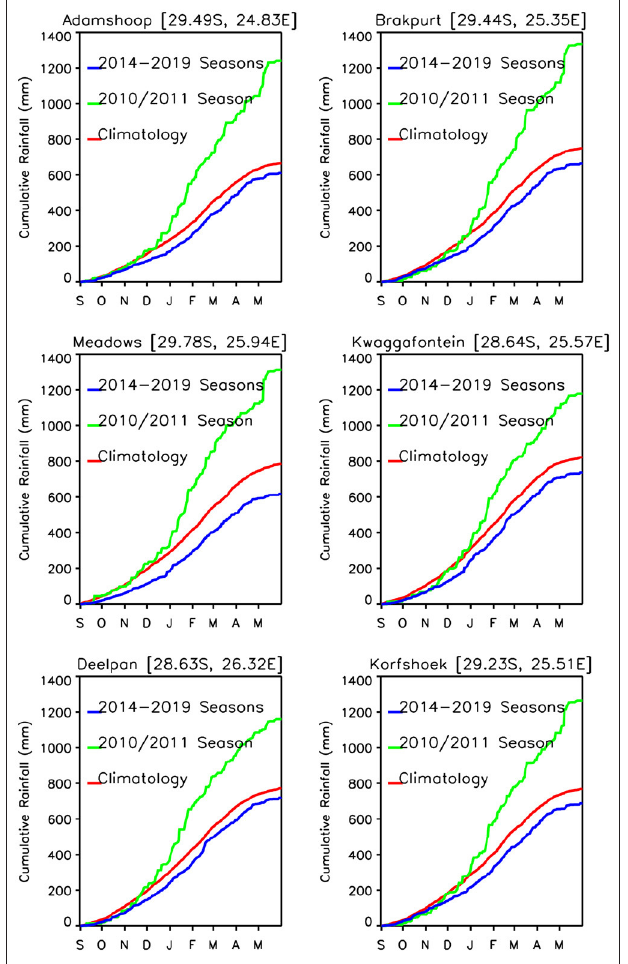
FIGURE 6 | Daily cumulative rainfall time series trajectories for epizootic period (2010/2011; green) and interepizootic period (average of 2014–2019; blue) compared to the daily long-term mean rainfall (red) for six selected study sites. The epizootic season (2010–2011) shown in green, was above the long-term mean, with a rainfall excess ranging between ∼ 200 and ∼ 600mm across study sites by May. The study post-epizootic/interepizootic period shows persistently below normal rainfall with a shortfall of ∼ 100mm by May across all study sites.